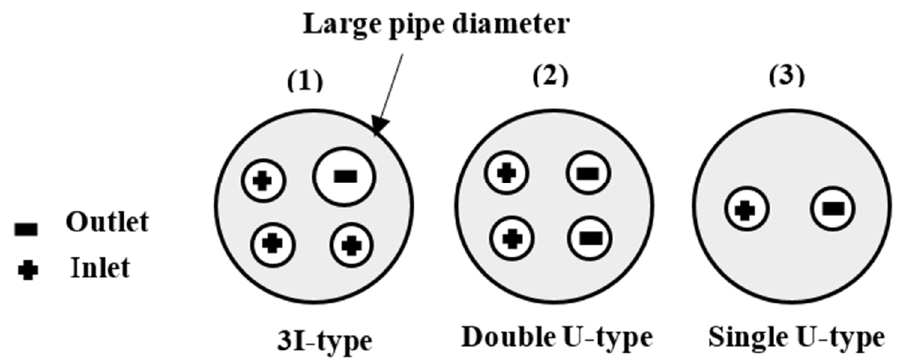
Figure 10. Cross section of the 3I-type, double U-tube, and single U-tube.